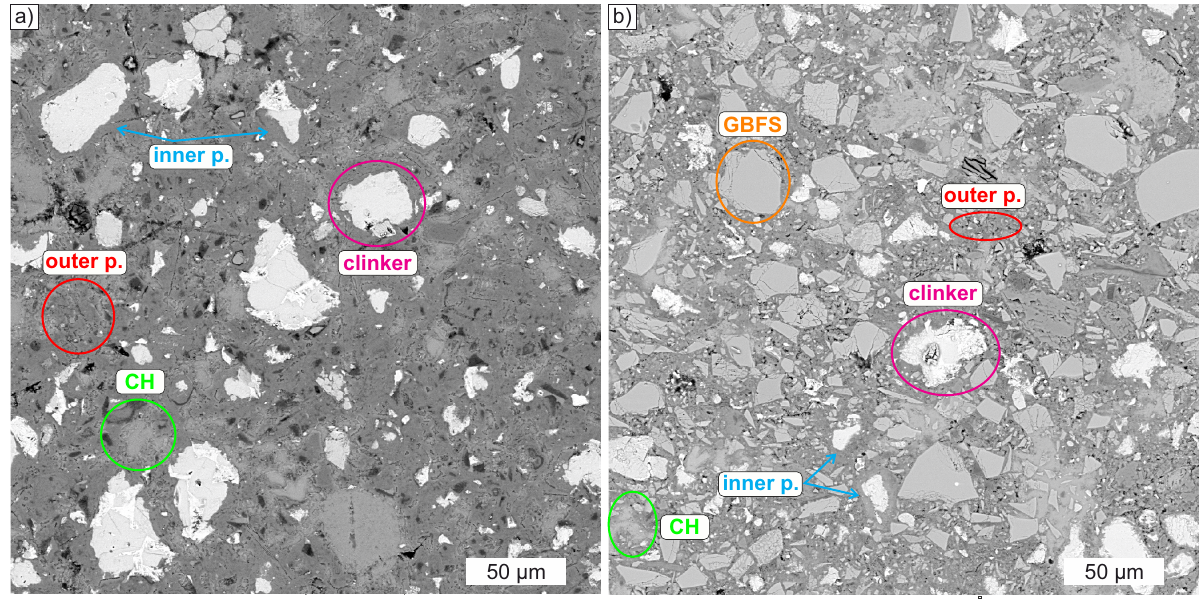
Figure 1. Typical SEM-BSE images of cement composites with highlighted phases a) PC b) SL.